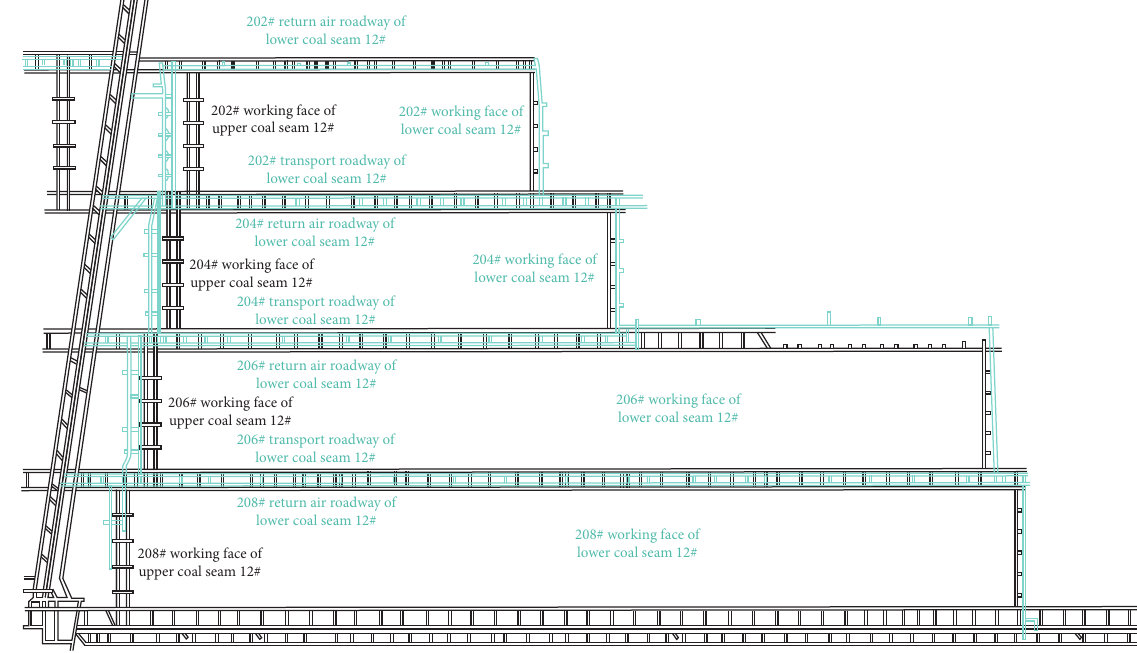
2 direct injection.